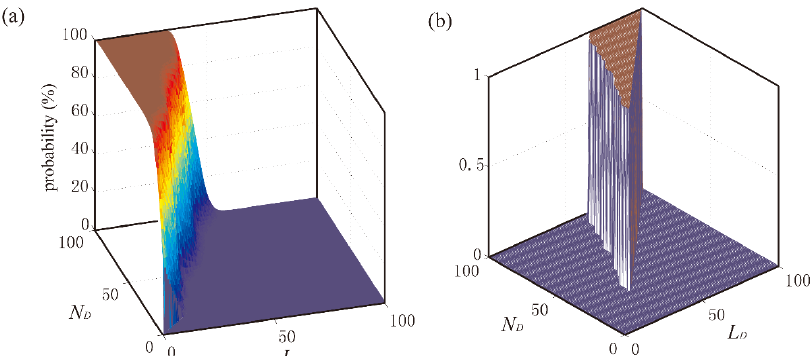
Figure 9. Parameter optimum for descending window. ( a ) Using traversing search method to optimize L D and N D for descending window, ( b ) Search the optimal L D and N D when testing probability is zero.